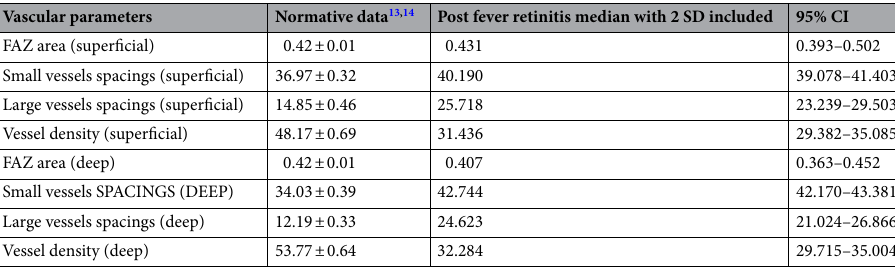
Table 2. Showing the vascular variable parameters of small and large vessels in superficial capillary and deep capillary layers of our series against age matched normal. Normal age group: 20–67 years. Our series: 18–72 years.